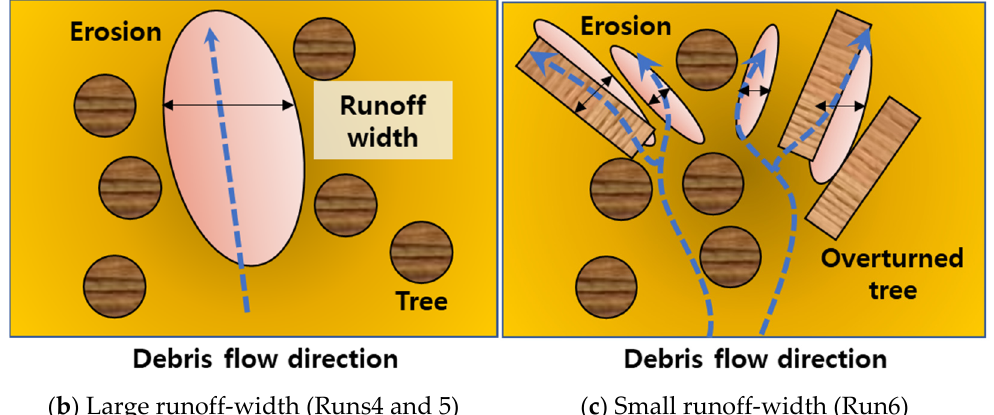
Figure 10. Spatial patterns of trees and driftwood (note that in the case of the overturned and fixed trees, the debris will be able to flow above the tree after the height of the debris flow exceeds the diameter of the fallen tree).